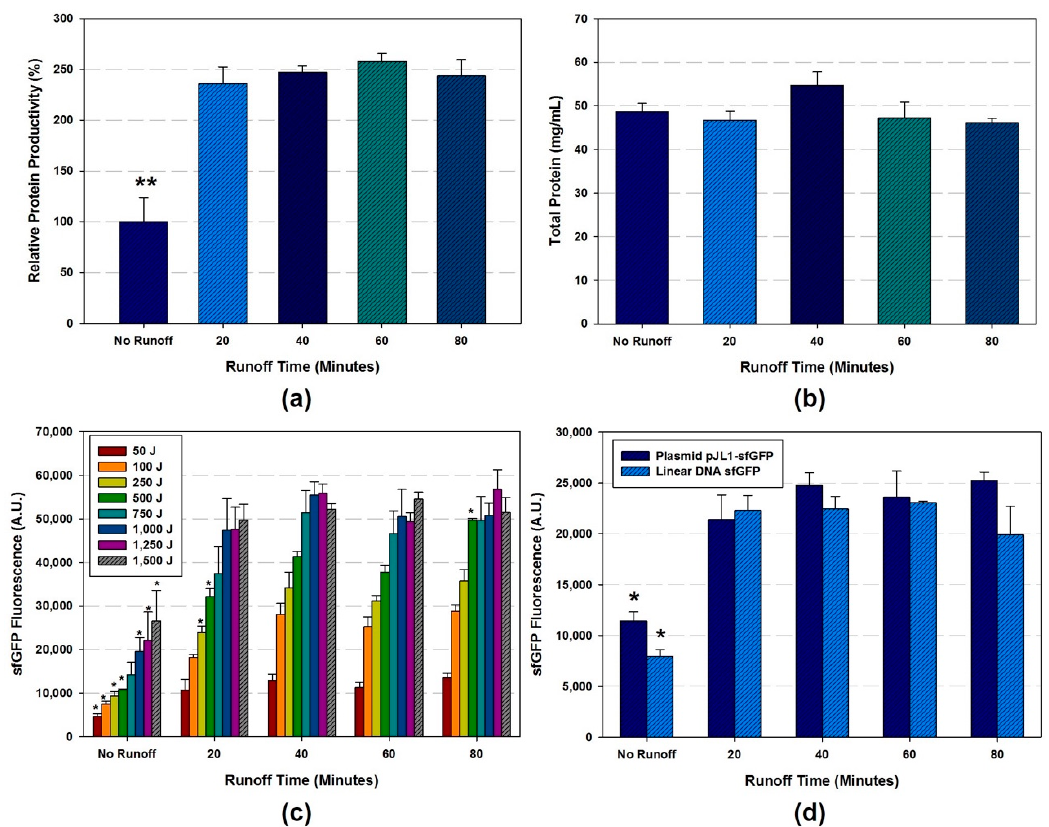
Figure 4. The effect of runoff reaction on protein productivity and total protein of the cell extract. ( a ) The relative protein productivity using the cell extract produced by different runoff reaction time ranged 0–80 min. Data depicted as the mean ± SD ( n = 3); ** p < 0.001 according to one-way analysis of variance (ANOVA) ( b ) The total protein concentration in the cell extract treated with different runoff reaction time. For Figure 4a,b, the same cell lysate was used with the sonication condition of 1500 Joules of sonication input and 1000 μ L of processing volume. ( c ) The effect of runoff at different lysis condition. All lysis procedure was fixed to 1000 μ L of processing volume for sonication with different energy input ranged from 50 to 1500 Joules. Data depicted as the mean ± SD ( n = 3), * p < 0.001 according to one-way analysis of variance (ANOVA). ( d ) CFPS reaction with runoff time variants on plasmid and PCR amplified linear template. Data depicted as the mean ± SD ( n = 3), * p < 0.05 according to one-way analysis of variance (ANOVA).